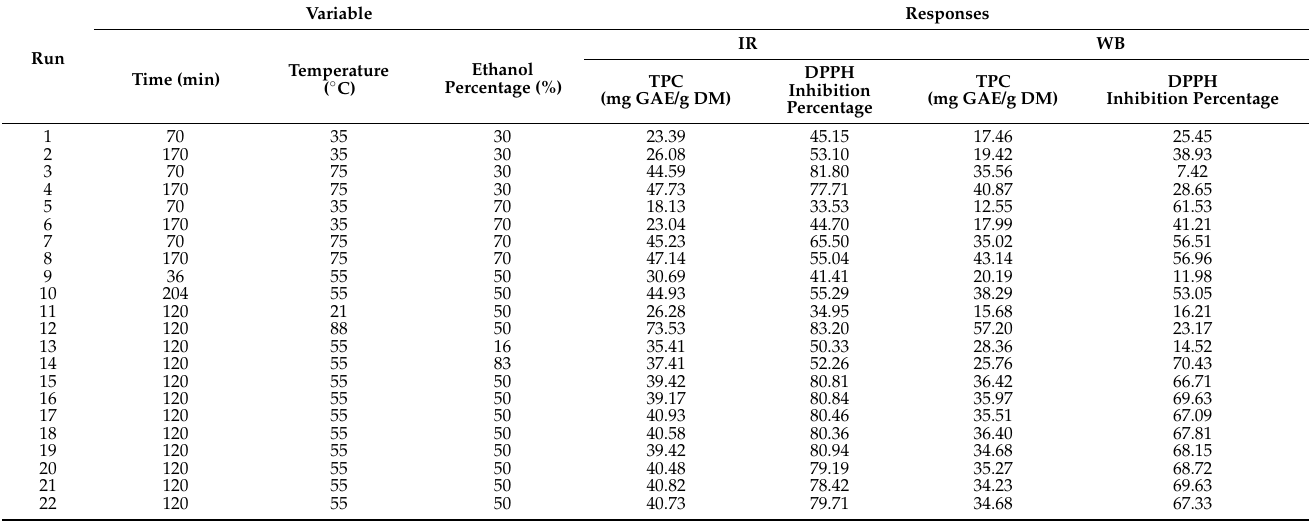
Table 1. Central composite arrangement for independent variables and their responses for TPC (mg GAE/g DM) and DPPH inhibition percentage.